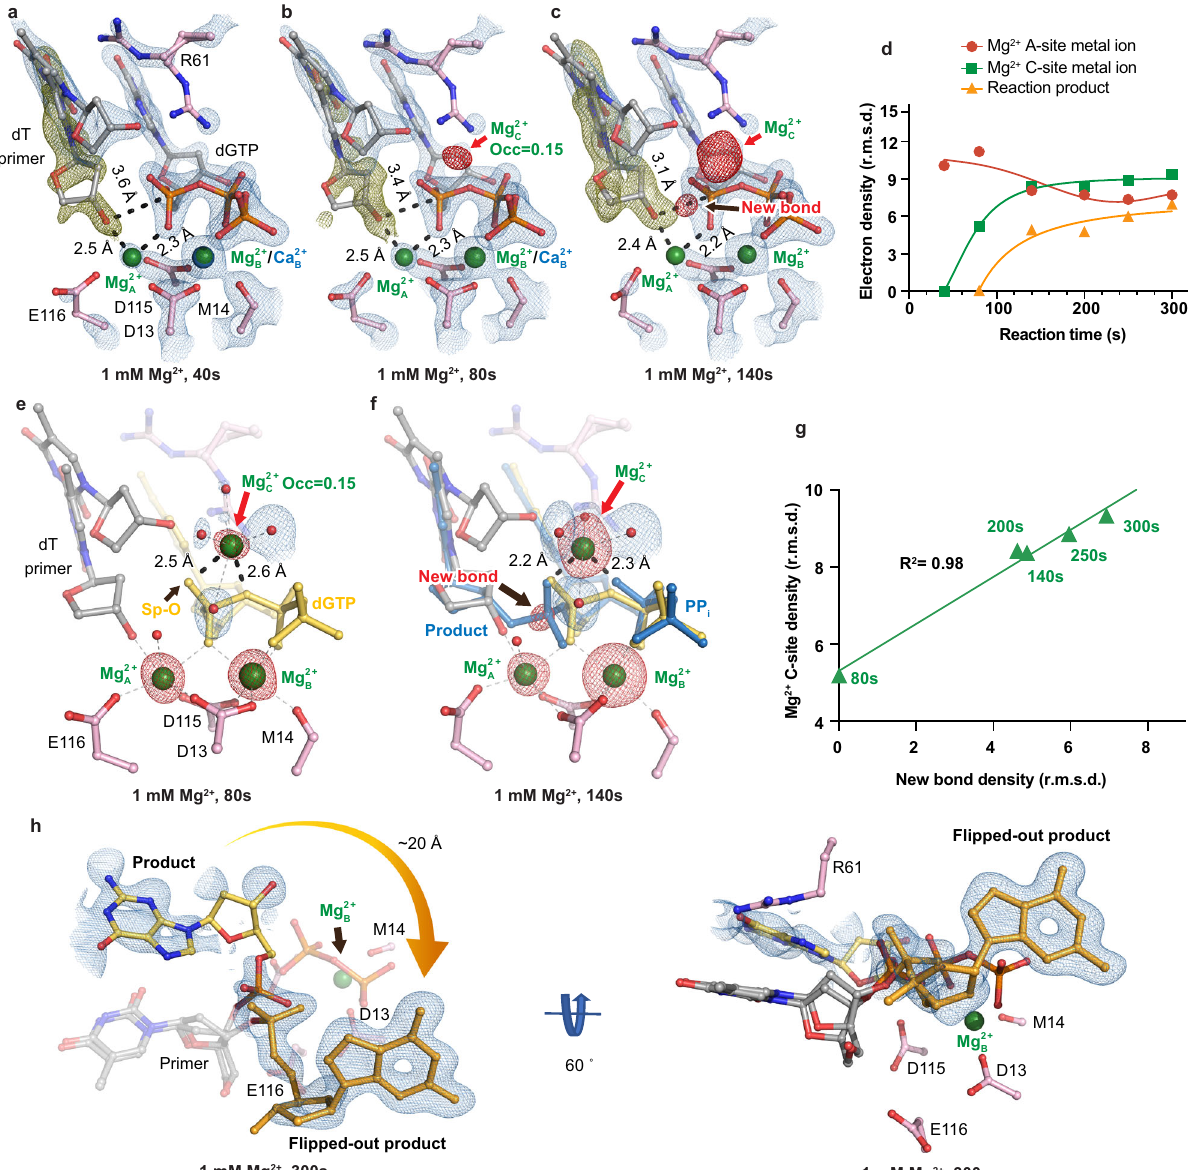
Fig. 2 In crystallo visualization of Pol η misincorporation with Mg 2 + . a – c Structures of Pol η during in crystallo catalysis after 1 mM Mg 2 + soaking for 40 s ( a ), 80 s ( b ), and 140 s ( c ). The 2F o -F c map for the primer up conformation (blue) was contoured at 1.2 σ . The 2F o -F c map for the Me 2 + A , Me 2 + B , dGTP, and catalytic residues (blue) was contoured at 2 σ in ( a – c ). The F o -F c omit map for the down conformation of the primer (green) was contoured at 3.3 σ in ( a – c) . The F o -F c omit map for all the Mg 2 + C , and newly formed bond (red) was contoured at 4 σ . d Timescale of Mg 2 + A , Mg 2 + C binding and reaction product in crystallo with Mg 2 + . e , f Observation of the Mg 2 + C after 1 mM Mg 2 + soaking for 80 s ( e ) and 140 s ( f ). g Correlation ( R 2 ) between the newly formed bond and the Mg 2 + C binding. d , g The data points represent singular measurements for r.m.s. density values of electron density. In ( e , f ), the 2F o -F c map for the water molecules that were coordinated by the Mg 2 + C was contoured at 0.7 σ . The F o -F c omit map for the Mg 2 + C , new bond, and Mg 2 + A and Mg 2 + B was contoured at 4 σ . h Alternative product state of Pol η in crystallo with 1 mM Mg 2 + at 300 s. The 2F o -F c map was contoured at 1 σ